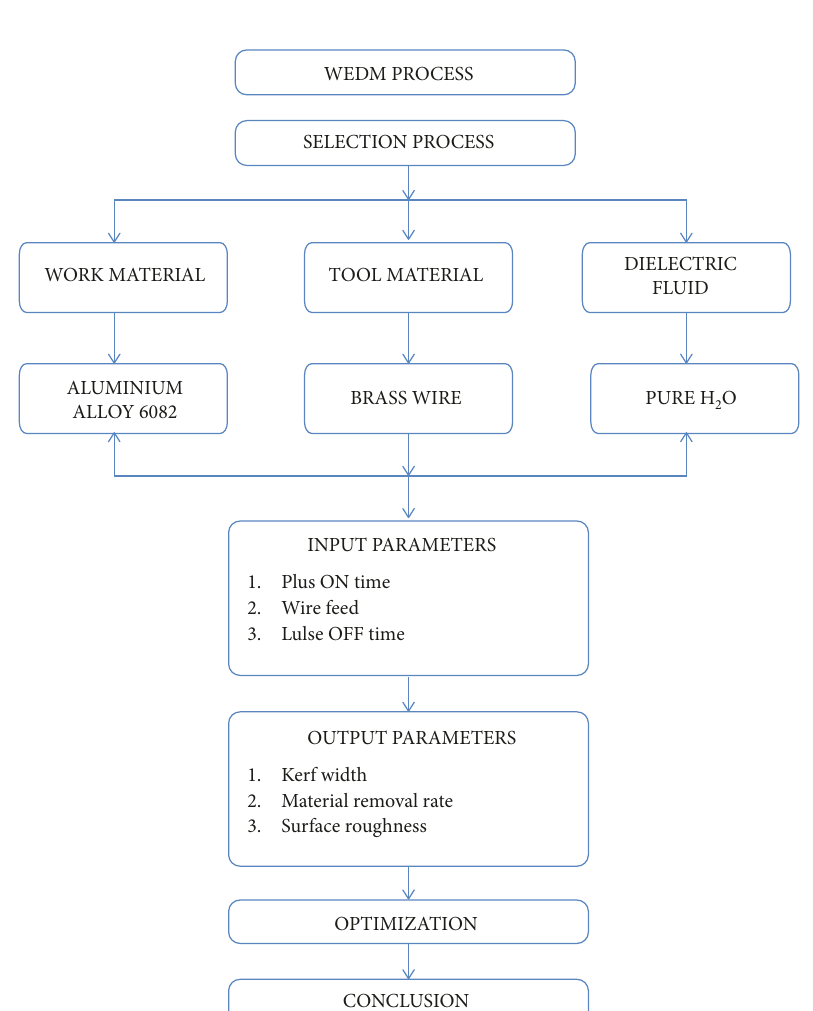
Figure 6: Methodology of WEDM process.